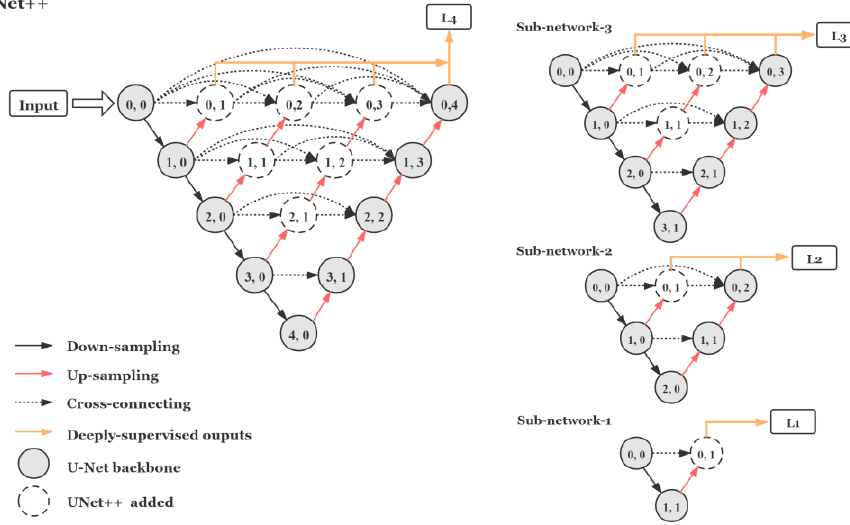
Figure 1. The UNet++ structure. It contains the basic U-Net backbone which is shown as gray circles in the figure. Firstly, it down-samples the input images through pooling layers at each level, then feature maps at each node get up-sampled and cross-connected with later nodes. Besides, UNet++ can be pruned during inference if trained with deep supervision. The sub-network at each level is shown on the left.